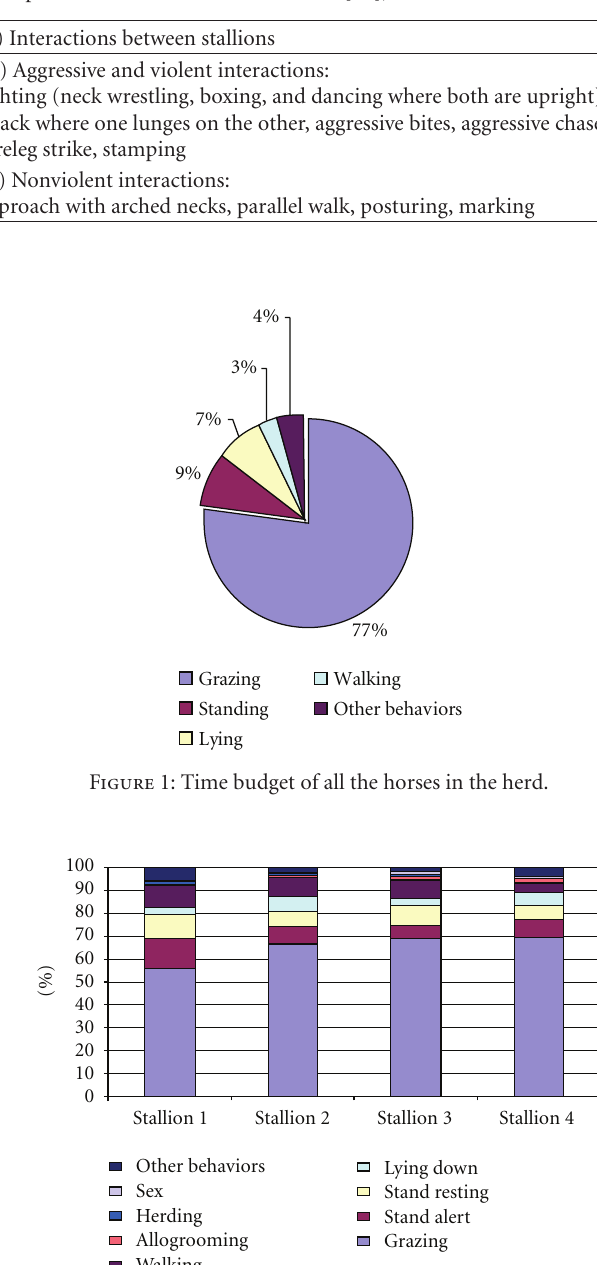
Table 2: Behavioural classes (for detailed descriptions of these behavioural acts see [25]).